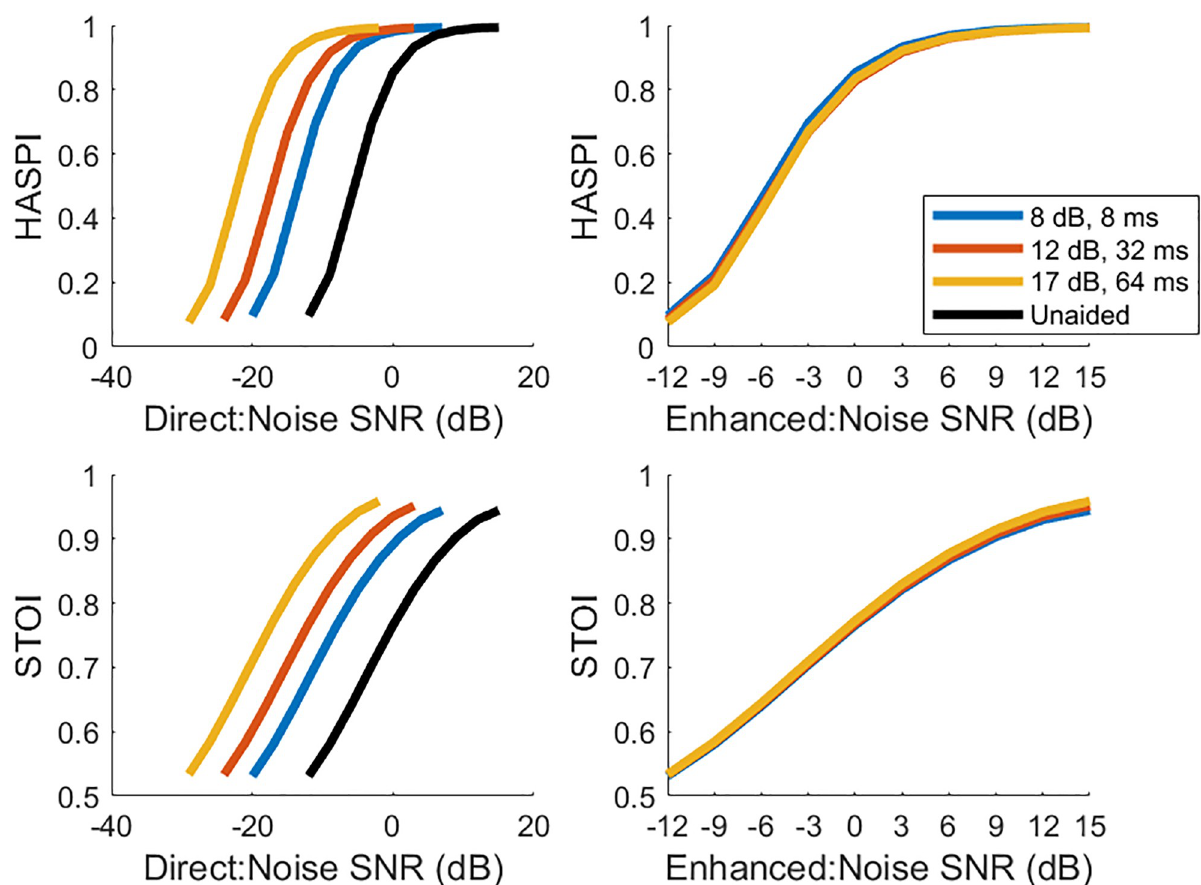
Fig 6. Intelligibility metrics. Left graphs show the HASPI and STOI (top and bottom, respectively) as a function of the direct path signal-to-noise ratio. Adding the various enhancements translates the curve by the corresponding amount of gain. Right graphs show the HASPI and STOI (top and bottom, respectively) as a function of the enhanced path signal-to-noise ratio. Regardless of the direct path signal level, the enhanced signal dominates the intelligibility calculation.